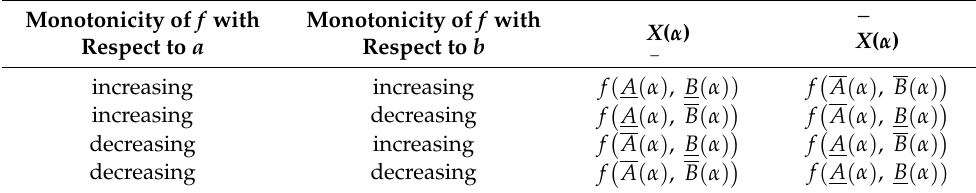
Table 1. Extremes of the α -cuts depending of the monotony of f . Monotonicity of f